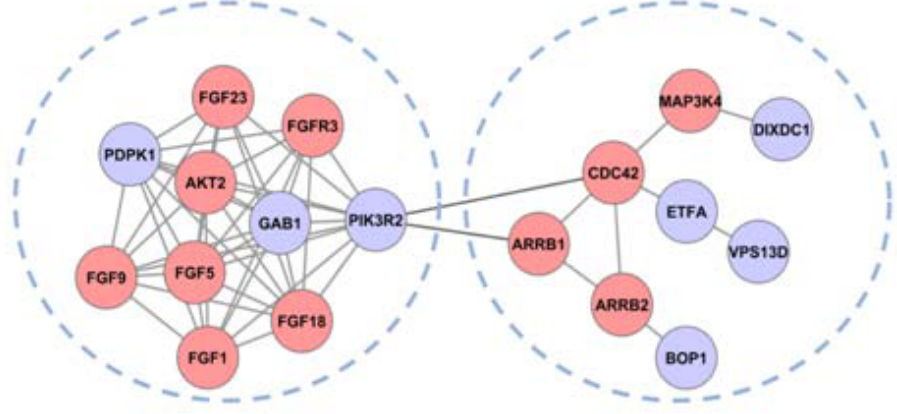
Figure 3: Example of a gene set formed by two subnets through functional merging. Dotted circles represent the initial subnets from network partitioning. Red nodes are proteins involved in MAPK signaling